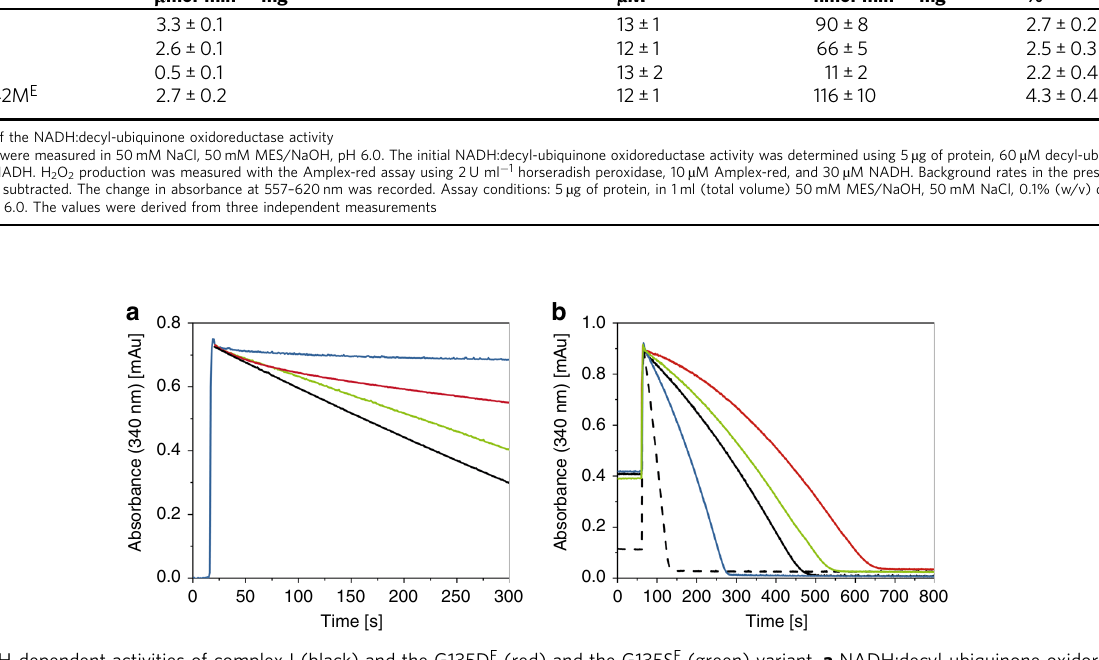
Table 2 Kinetic parameters and H 2 O 2 production by complex I and the variants Complex I variant